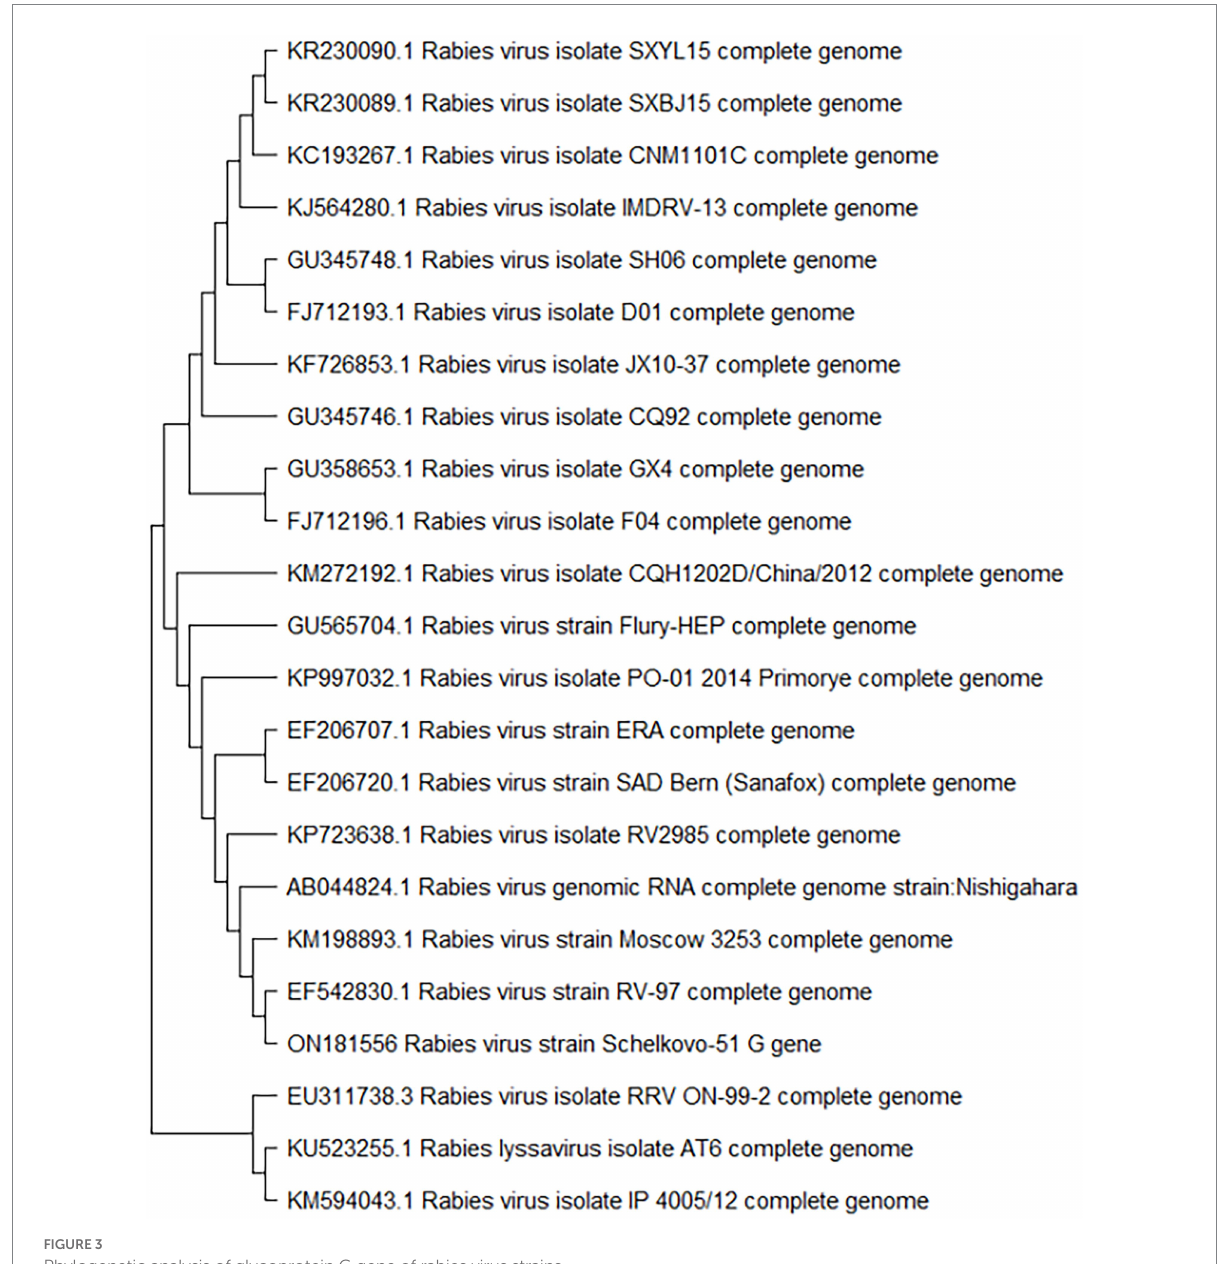
FIGURE 3 Phylogenetic analysis of glycoprotein G gene of rabies virus